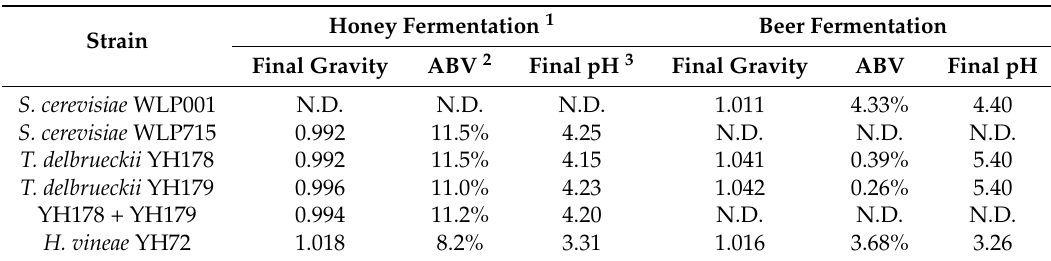
Figure 3. The T. delbrueckii isolates can ferment honey into mead. ( A ) The indicated strains were used to inoculate a honey solution, and fermentation of the honey was monitored with a digital hydrometer. The amount of alcohol produced is plotted vs. time. These results are representative of three independent fermentations for each strain or combination of strains (178/179 = a 1:1 mixture of YH178 and YH179 cultures). ( B ) Production-scale honey fermentations using a combination of YH178, YH179, and WLP715 yeasts. These fermentations were conducted in April (3 April 2017) and September (18 September 2017) of 2017 under similar conditions but with slightly different starting gravities of the honey solution. Experimental fermentations with Saccharomyces cerevisiae , Torulaspora delbrueckii , and Hanseniaspora vineae